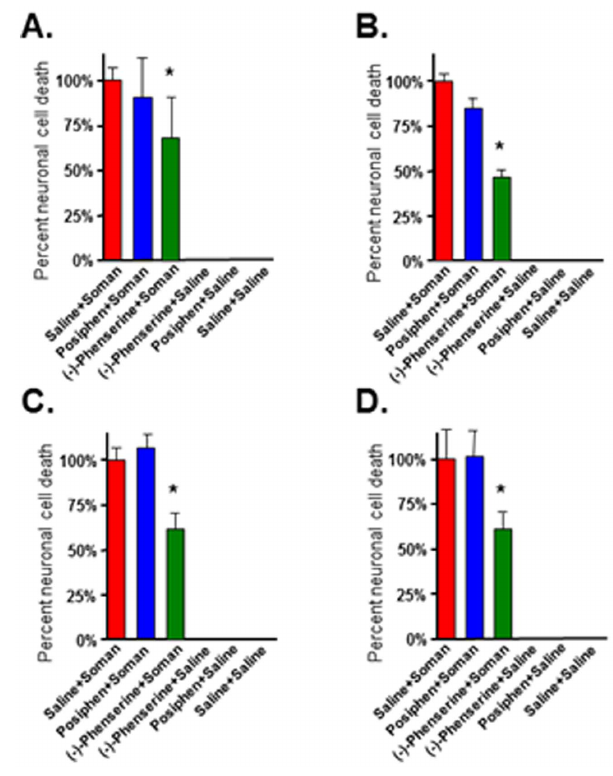
Figure 5. Administration of ( 2 )-phenserine injected intrave- nously 5 min after soman protects neurons against soman- induced neuronal cell death. Rats were post-treated with ( 2 )- phenserine, posiphen, or saline five minutes after soman. Three representative images were acquired from each of the four brain regions per animal. The number of fluorescein-positive neurons was counted by an investigated that was blinded to the treatment. The bar represents the average percent neuronal cell death 6 SD in the pirform cortex (A), hippocampus (B), basolateral amygdala (C), cingulate cortex (D). n=6/group. *p , 0.001 vs soman/saline by ANOVA + Tukey post hoc analysis.